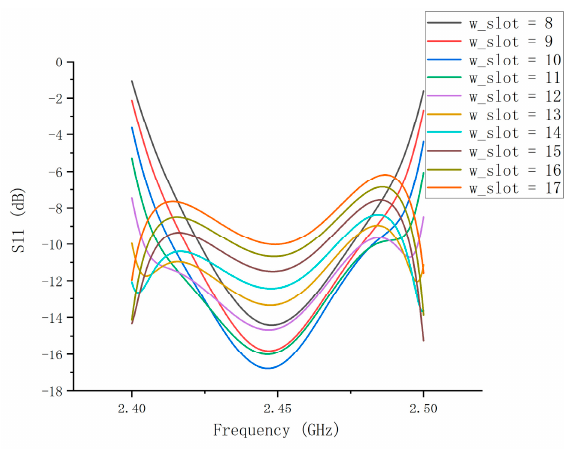
Figure 5. Comparison of S11 among different W_slot values.